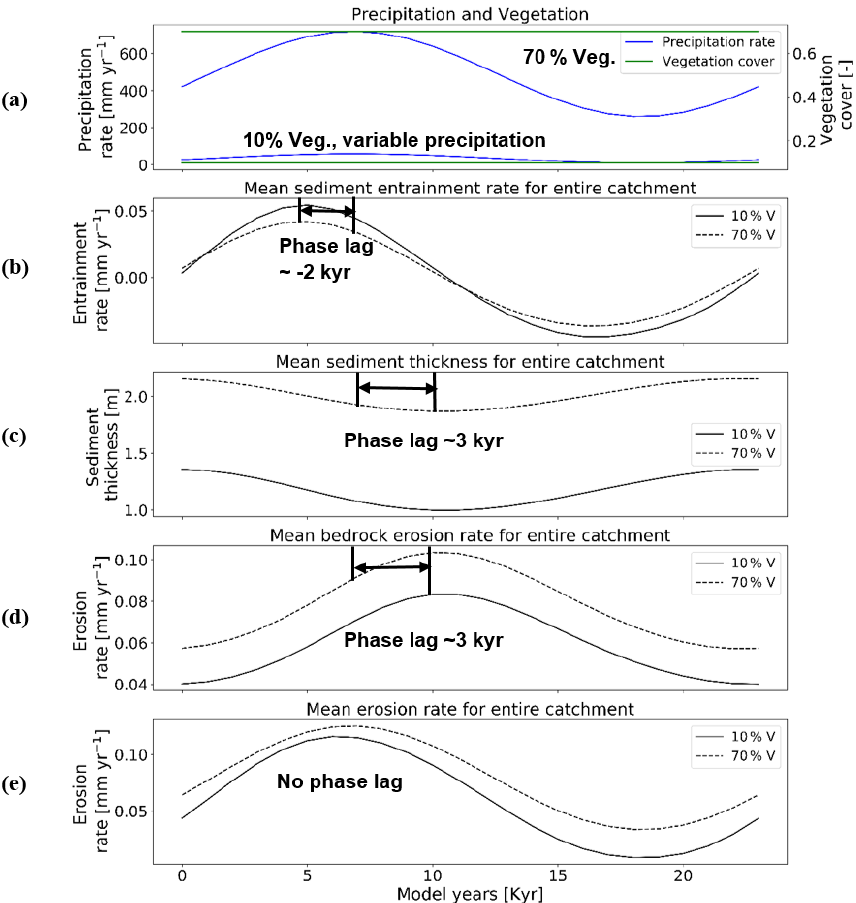
Figure 5. Temporal evolution of catchment-averaged predictions for scenario 1 described in the text (Sect. 3.1). Graphical representation of mean catchment sedimentation and erosion to (a) oscillating precipitation [mmyr − 1 ] and constant vegetation cover [–] in terms of (b) sed- iment entrainment [mmyr − 1 ], (c) sediment thickness [m], (d) bedrock erosion [mmyr − 1 ], and (e) mean erosion rates [mmyr − 1 ] for the entire catchment. The periodicity of climate and vegetation oscillations is 23kyr with a rock uplift rate of 0.5mmyr − 1